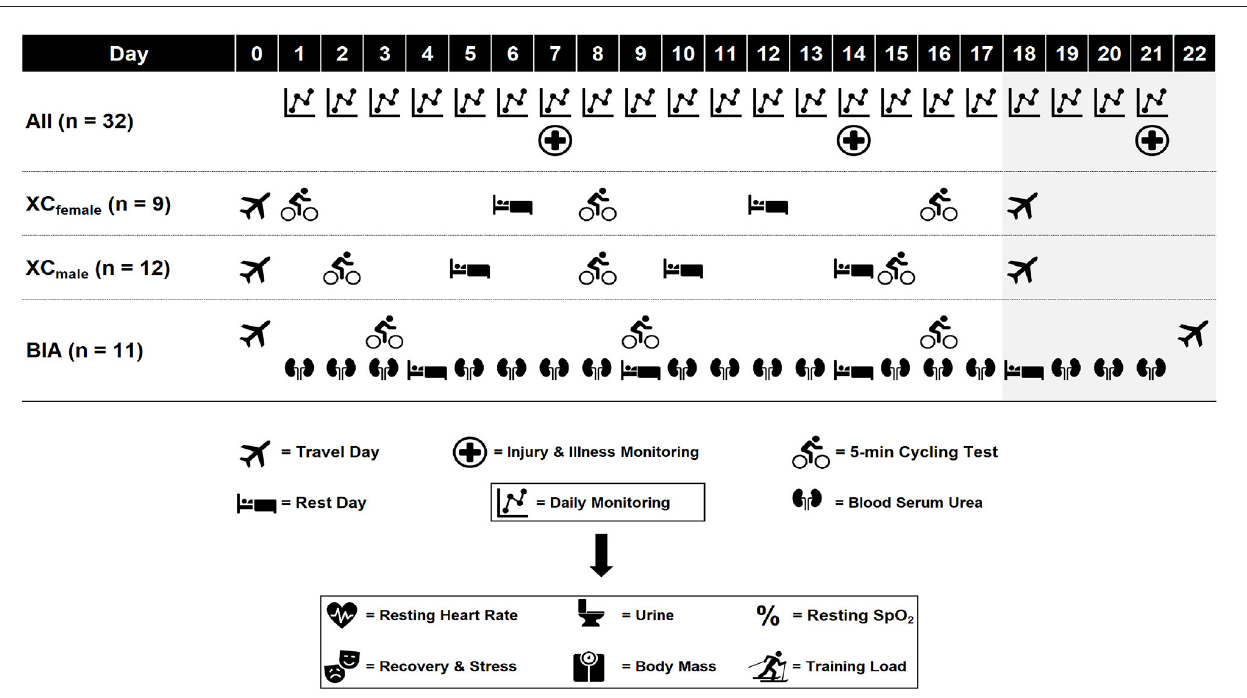
* Significantly different from the women within the same sport (p < 0.05). # Significantly different from the cross-country skiers of the same sex (p < 0.05). BMI, body mass index; ˙VO 2 peak , peak oxygen uptake.